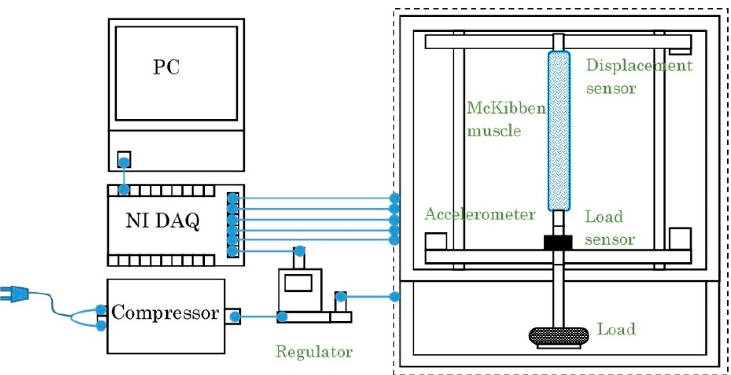
Figure 1. Vertical load system.